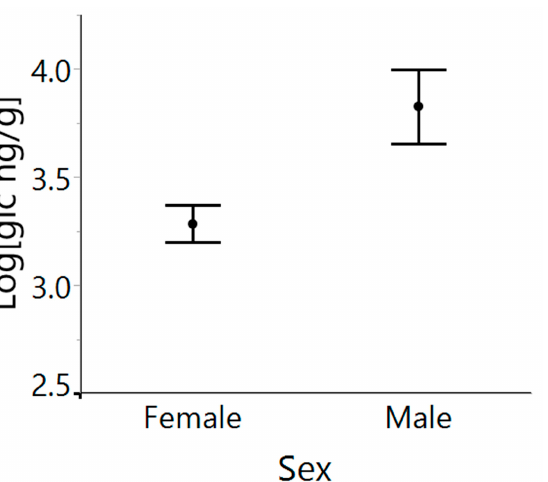
Figure 4. Sex difference in fecal glucocorticoid metabolites during the pre-breeding 2017–2018. Males had higher fecal glucocorticoid metabolite levels than females during the pre-breeding season. These samples include individuals from Rio Abajo captive populations (Rio Abajo males = 10, Rio Abajo females = 11). Graphs shows means ± SE.